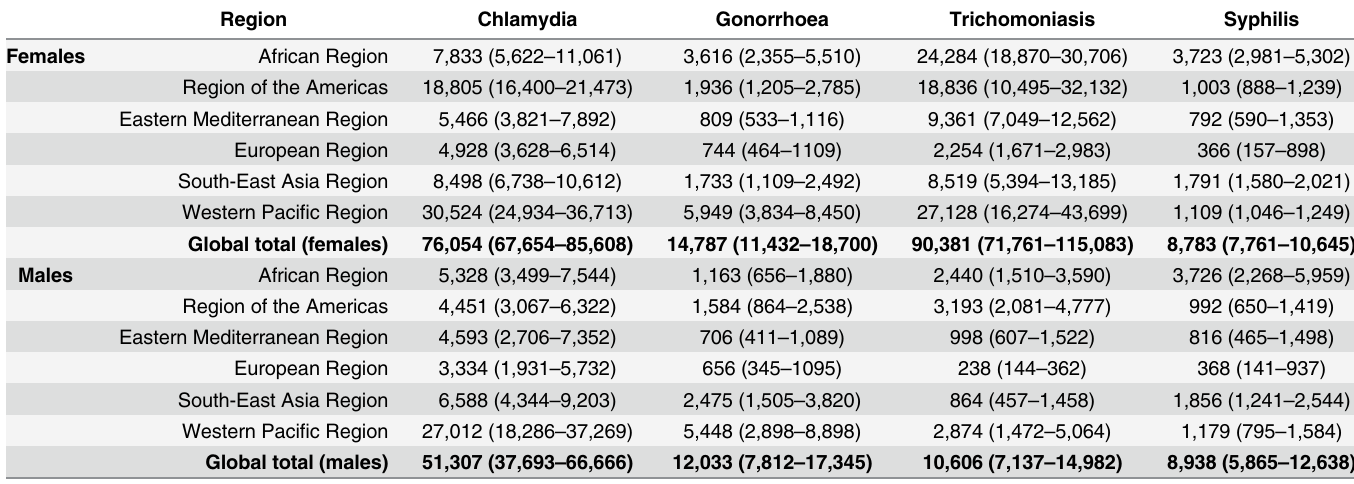
Table 4. Global and regional estimates of the number of prevalent cases (thousands) in 2012 by infection and sex (95% UI shown in parentheses).